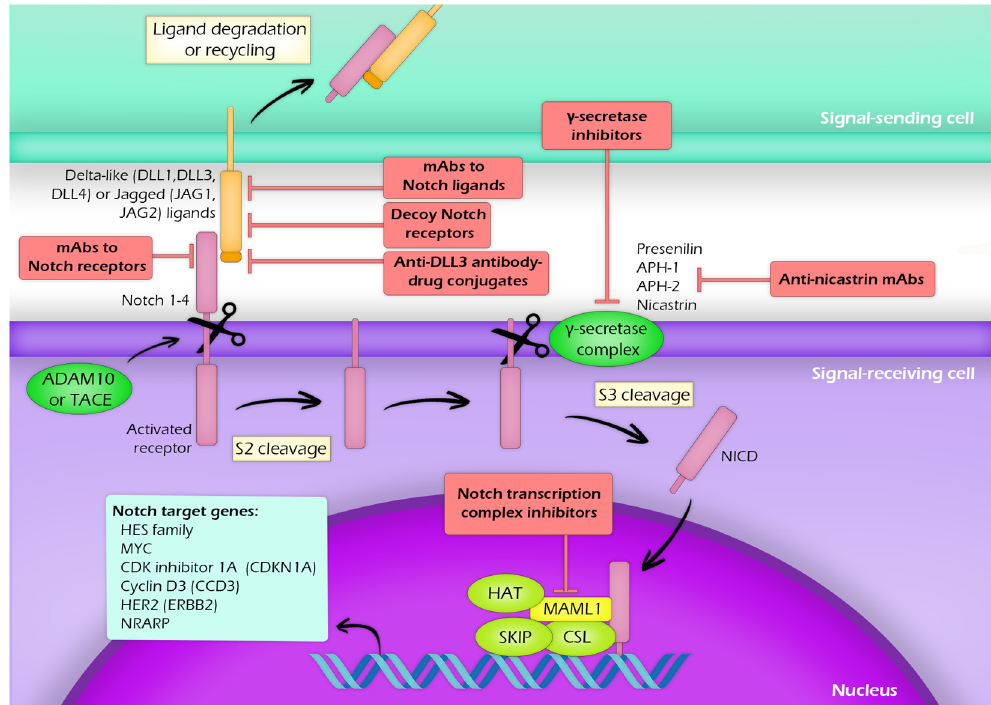
Figure 1. NOTCH1 signaling pathway and potential inhibitory strategies.